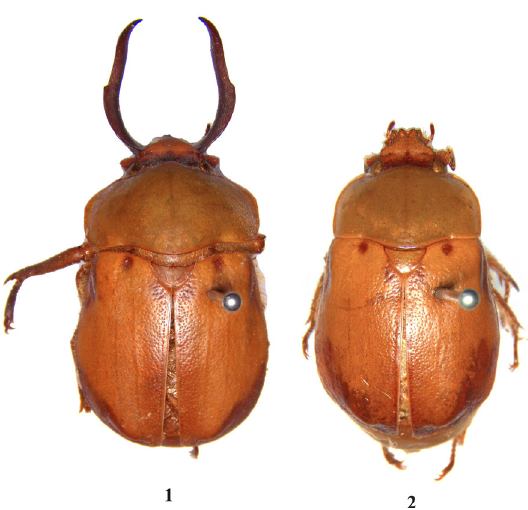
Figs 1–2. Pukupuku arunachalensis sp. nov. 1 . Holotype, ♂, habitus, dorsal view. 2 . Paratype, ♀, habitus, dorsal view.